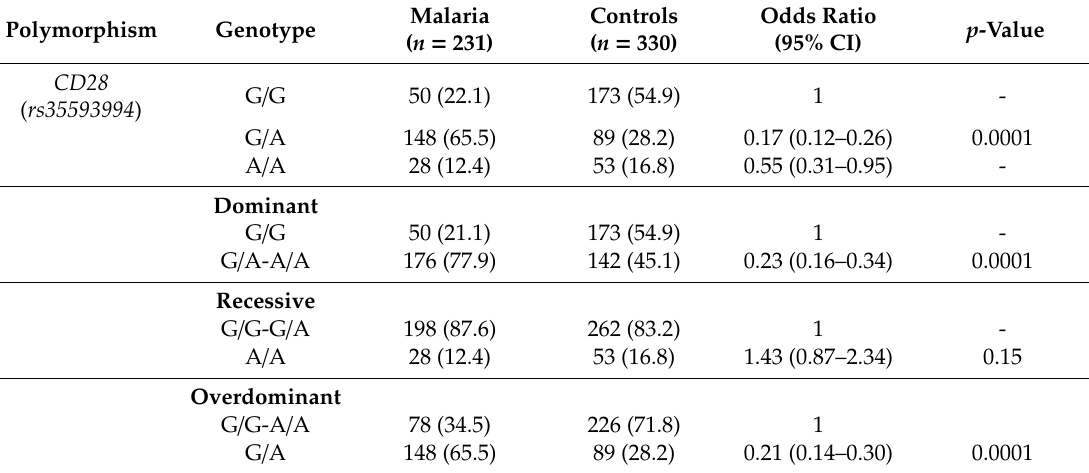
Table 2. Genotypic frequency of the CD28 gene promoter polymorphism between malaria-infected and control